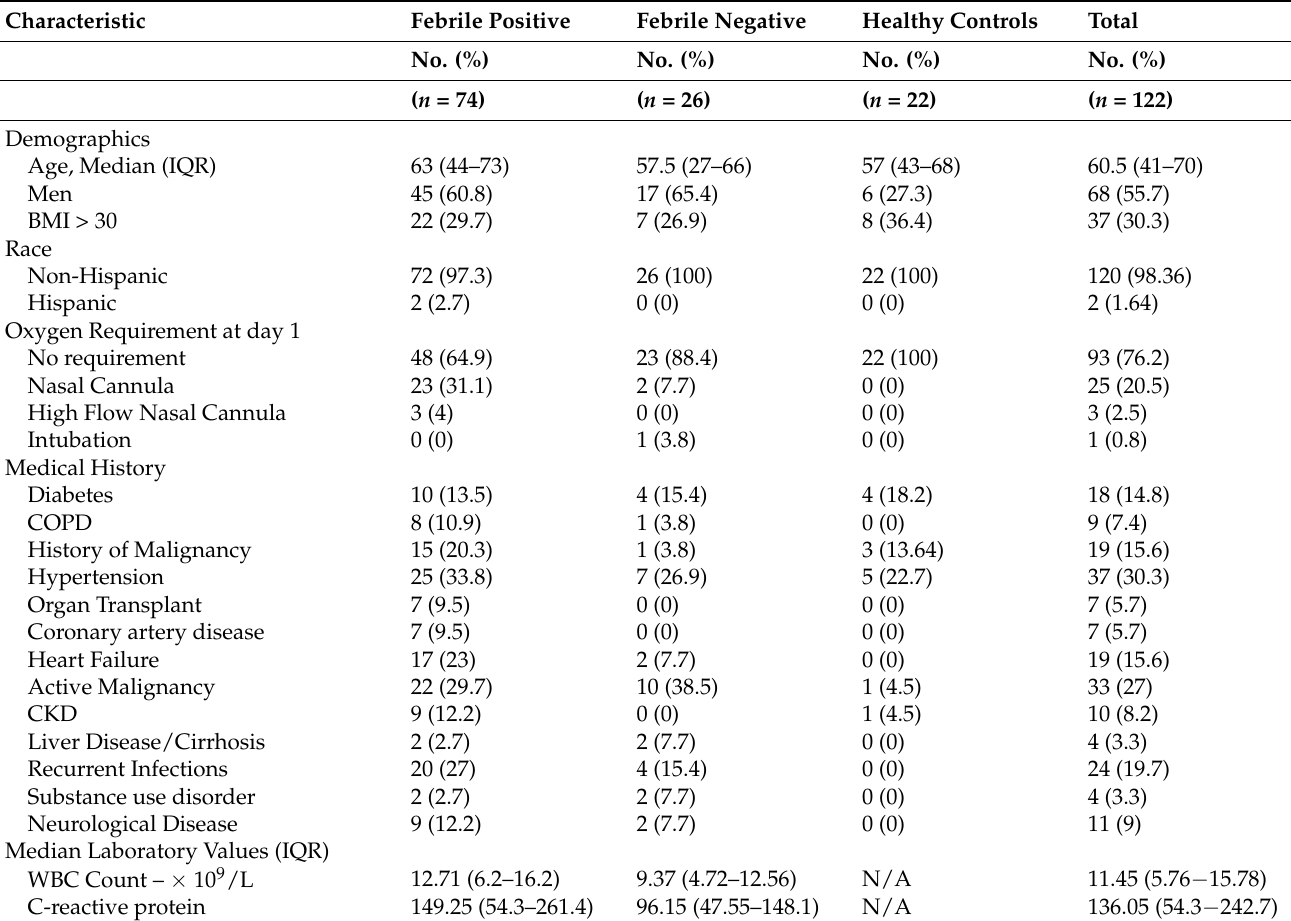
Table 1. Patient demographics and